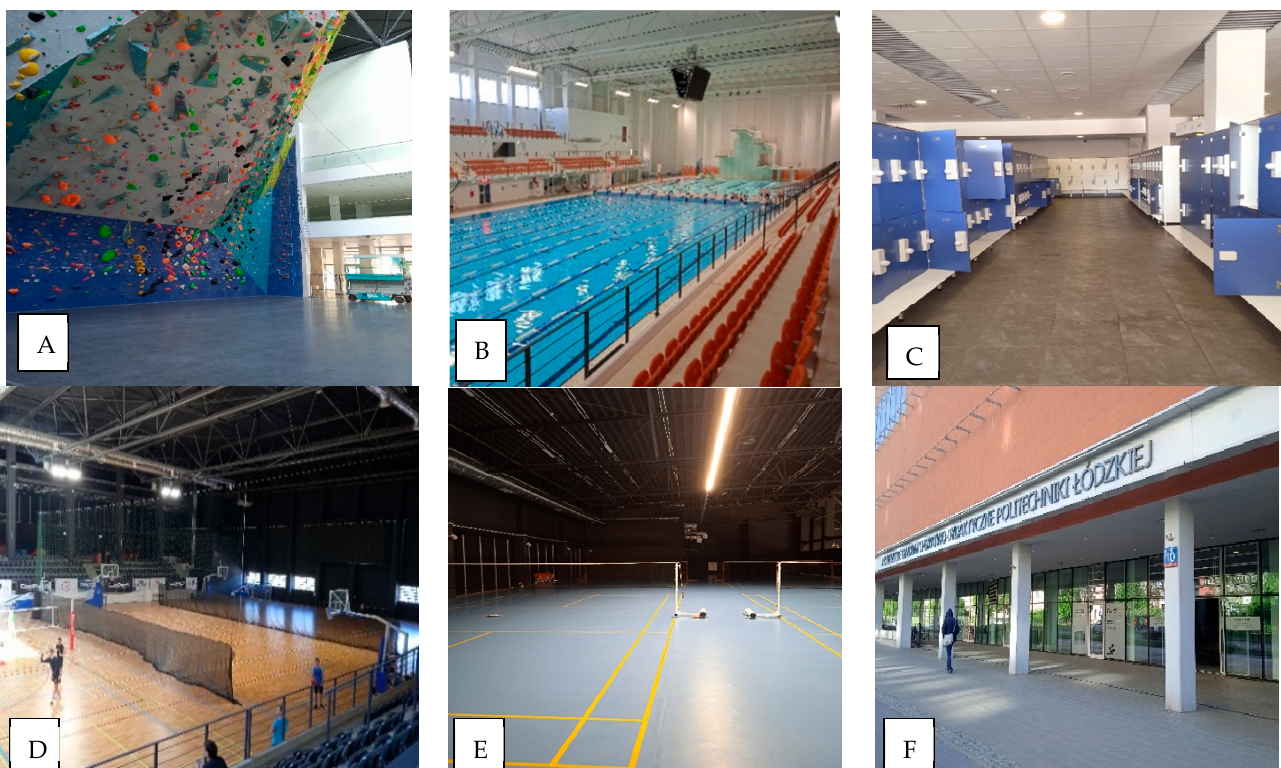
Figure 1. Analysed locations: ( A ) “climbing wall”, ( B ) “swimming pool”, ( C ) “changing room at the swimming pool” ( D ) “basketball/volleyball court”, ( E ) “badminton court”, and ( F ) “entrance to the building”.